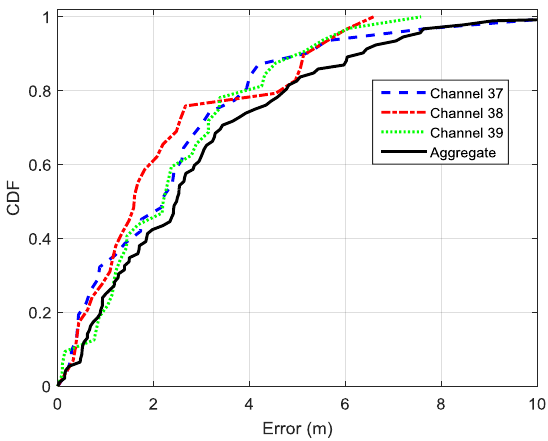
Figure 8. CDFs of distance estimation errors for the selected BLE beacon by using separate PRM and aggregate PRM.